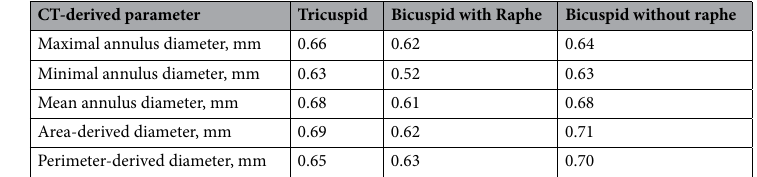
Table 3. Correlation between surgical aortic valve size (tissue-annulus diameter) and CT-derived annulus diameters of three types of native aortic valves ( r , all data are p <